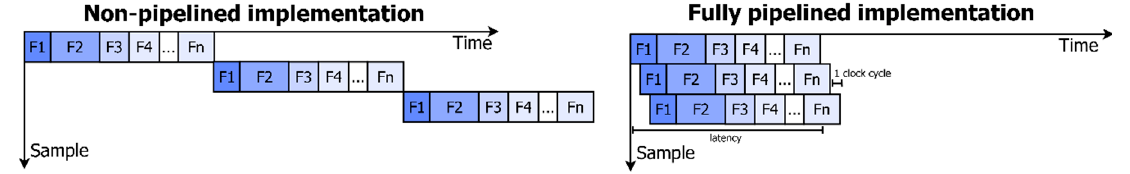
Figure 11. Graphical representation of the execution of functions on an FPGA.